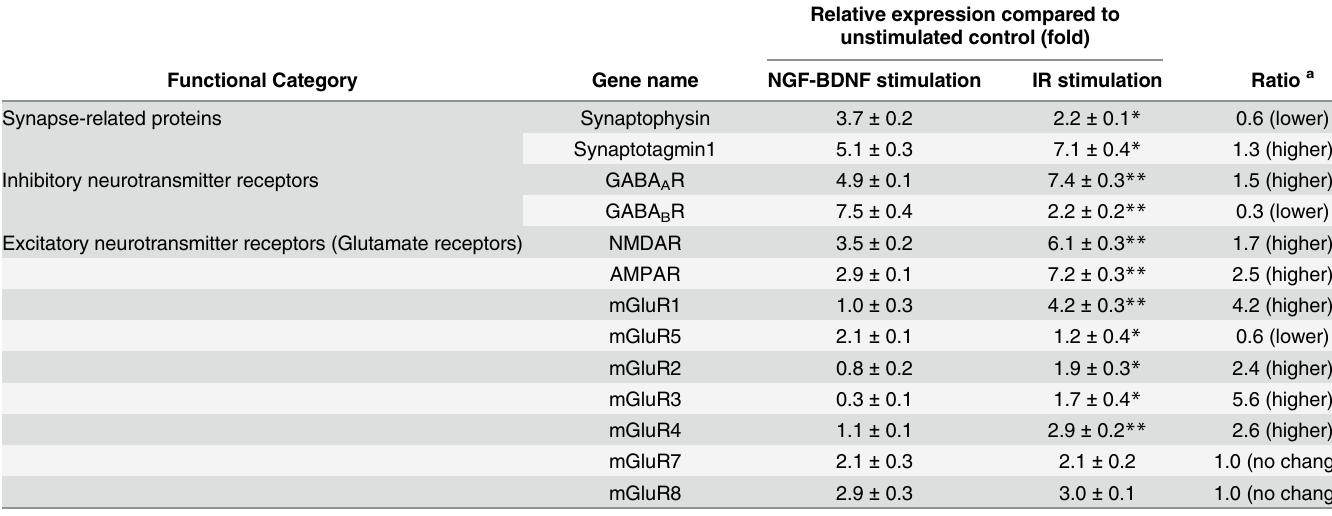
Table 3. Summary of expression profile of neuronal function-related genes in IR-stimulated and neurotrophin-stimulated C17.2 cells.